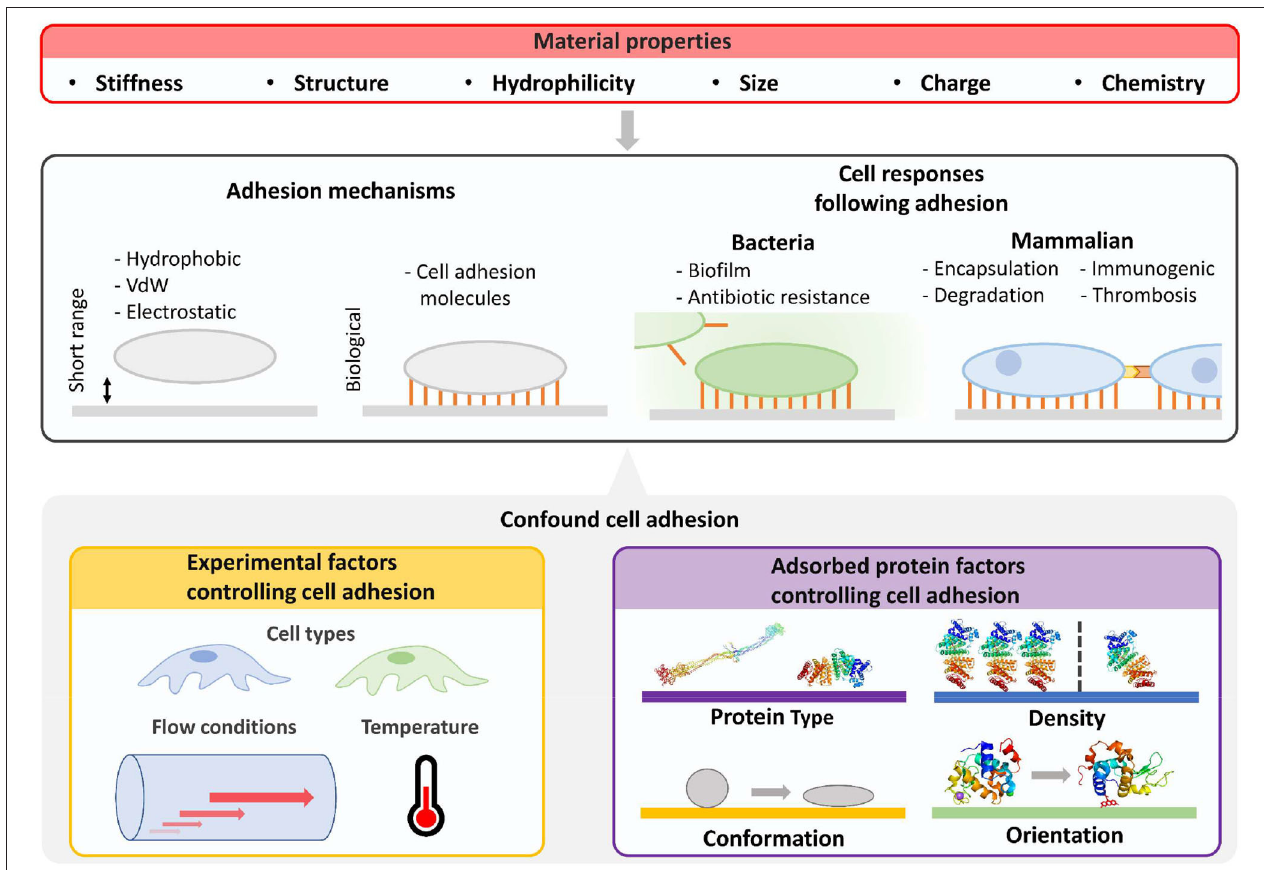
FIGURE 2 | Characterization of cellular fouling due to differences in material properties is confounded by experiment factors and properties of adsorbed surface proteins. Beyond material properties, the number and strength of surface adhered cells will be determined by cell type, flow conditions, and properties of adsorbed proteins such as type, density, orientation, and conformation. Cell responses will then be influenced by altering biofilm formation for bacteria and potential immune responses in mammalian environments. Furthermore, biologically mediated material degradation may occur. Images of PDB IDs 1EI3 ( Yang et al., 2000), 1BJ5